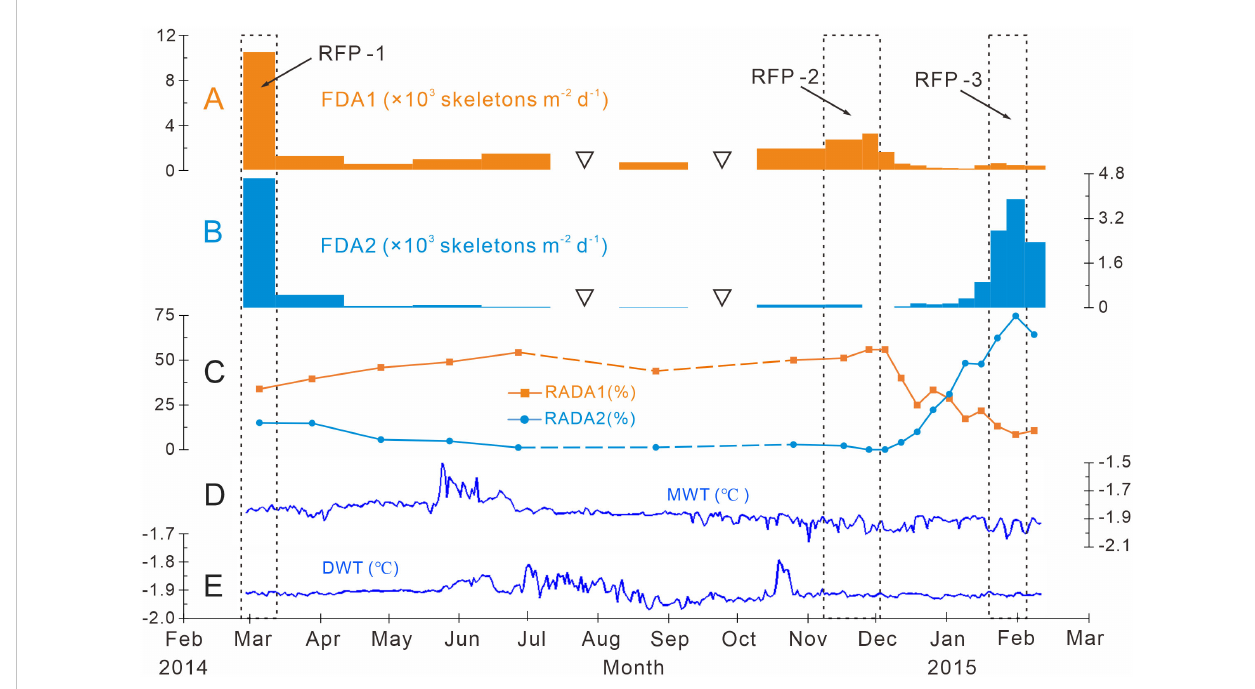
FIGURE 6 Time-series variations of the fl uxes and relative abundances of the dominant assemblages with water temperatures measured at Station M8 in Prydz Bay polynya. (A) FDA1, fl ux of dominant assemblage one (the group of small-sized taxa). (B) FDA2, fl ux of dominant assemblage two. (C) RADA1, relative abundance of dominant assemblage one; RADA2, relative abundance of dominant assemblage two. (D) MWT, medium-depth water temperature recorded by a sensor moored at 282 m. (E) , DWT, deep-water temperature recorded by a sensor moored at 582 m. The data sets in (D) and (E) were provided by the National Arctic and Antarctic Data Center (http://www.chinare.org.cn). The black dotted boxes indicate RFP-1 – 3. The width of the histogram bars indicates the sampling intervals, and the black hollow inverted triangles indicate samples that were not analyzed because the sample size was too small.